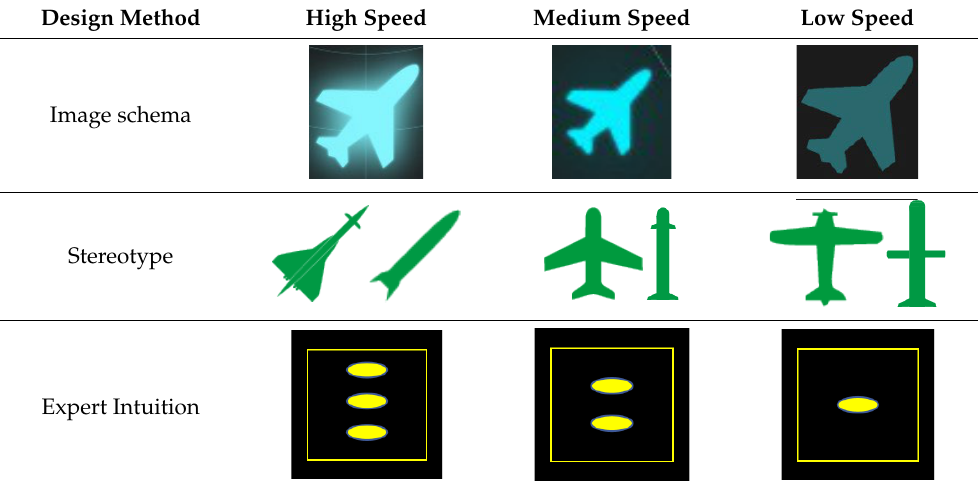
Table 2. Image schema list.